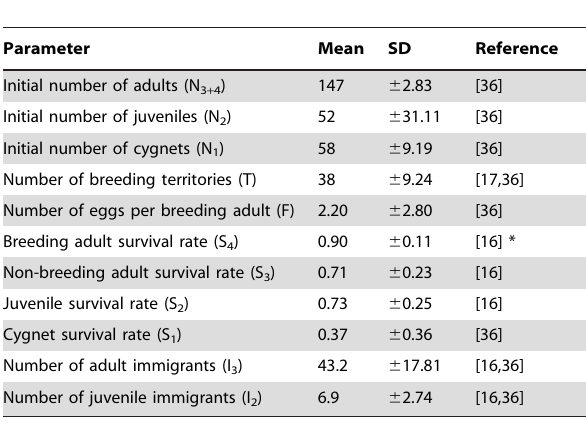
Table 1. Population model parameter mean values and standard deviations; see text for